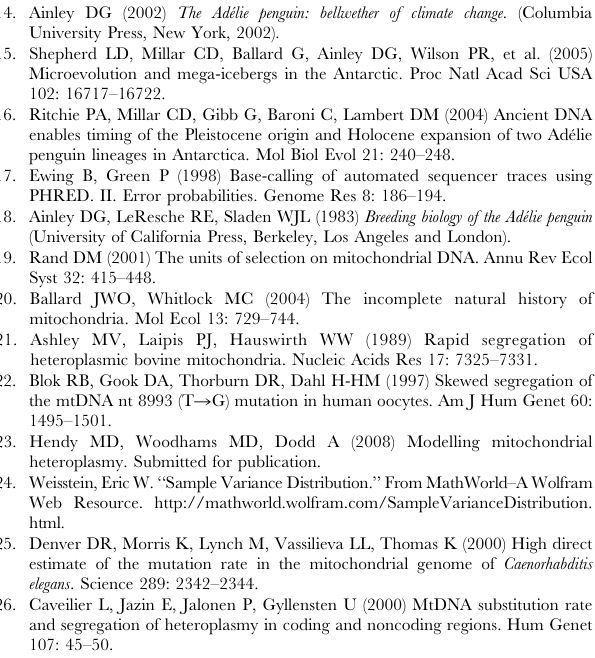
Figure S1 Position dependency of heteroplasmy ratios. Com- bined plot of expected versus observed heteroplasmy ratios for haplotype mixes, as shown by different colours.